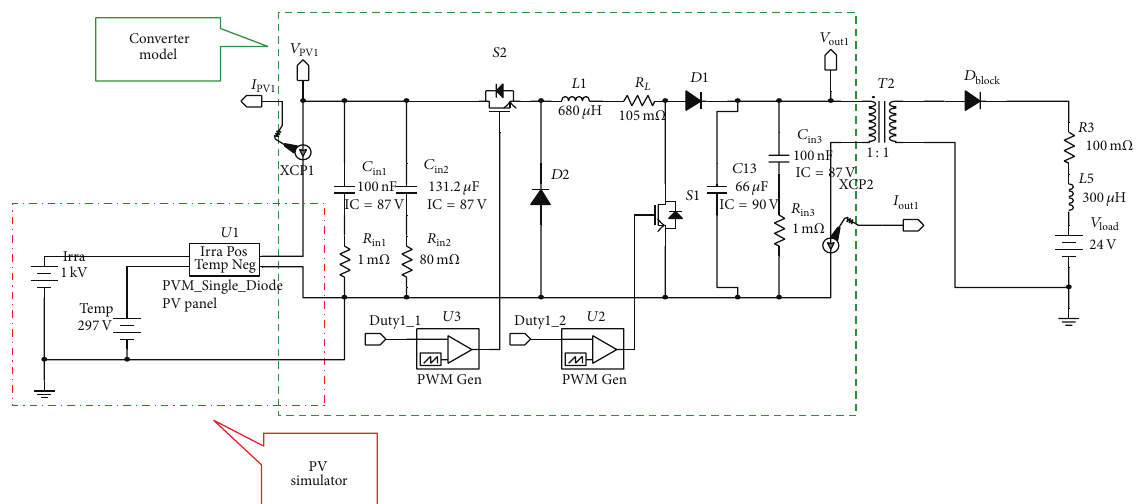
Figure 15: Multisim program for transient analysis of the DC/DC converter connected to a PV